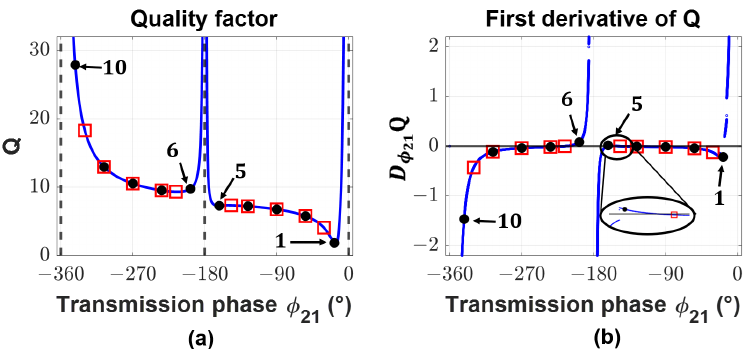
Figure 8. ( a ) The quality factor of the metasurface unit cells versus transmission phase. ( b ) The first derivative of the quality factor with respect to the transmission phase. The solid black circles indicate the values corresponding to the linear phase gradient and the hollow red squares indicate the adjusted values used for the perturbed phase